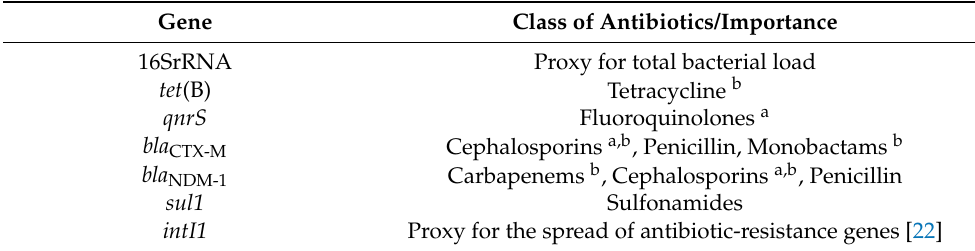
Table 1. Marker genes and the class of drugs to which they encode